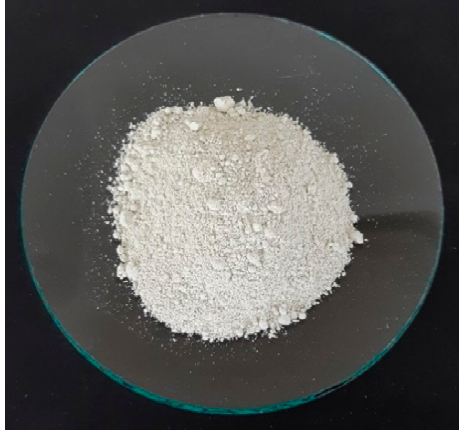
Figure 2. Macroscopic image of the ZeoBau 0–50 μ m natural zeolite.